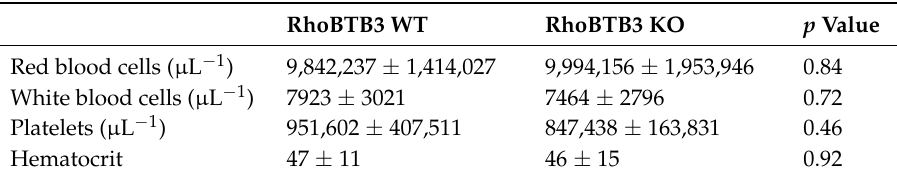
Table 1. Hematology features of RhoBTB3 deficient mice. Counts were assessed with a Neubauer counting chamber. Hematocrit is expressed as percentage fraction of total. Data represents the average ± SD from 10 (hematocrit) or 11 (cell counts) animals of each genotype. P values are calculated from Student’s t